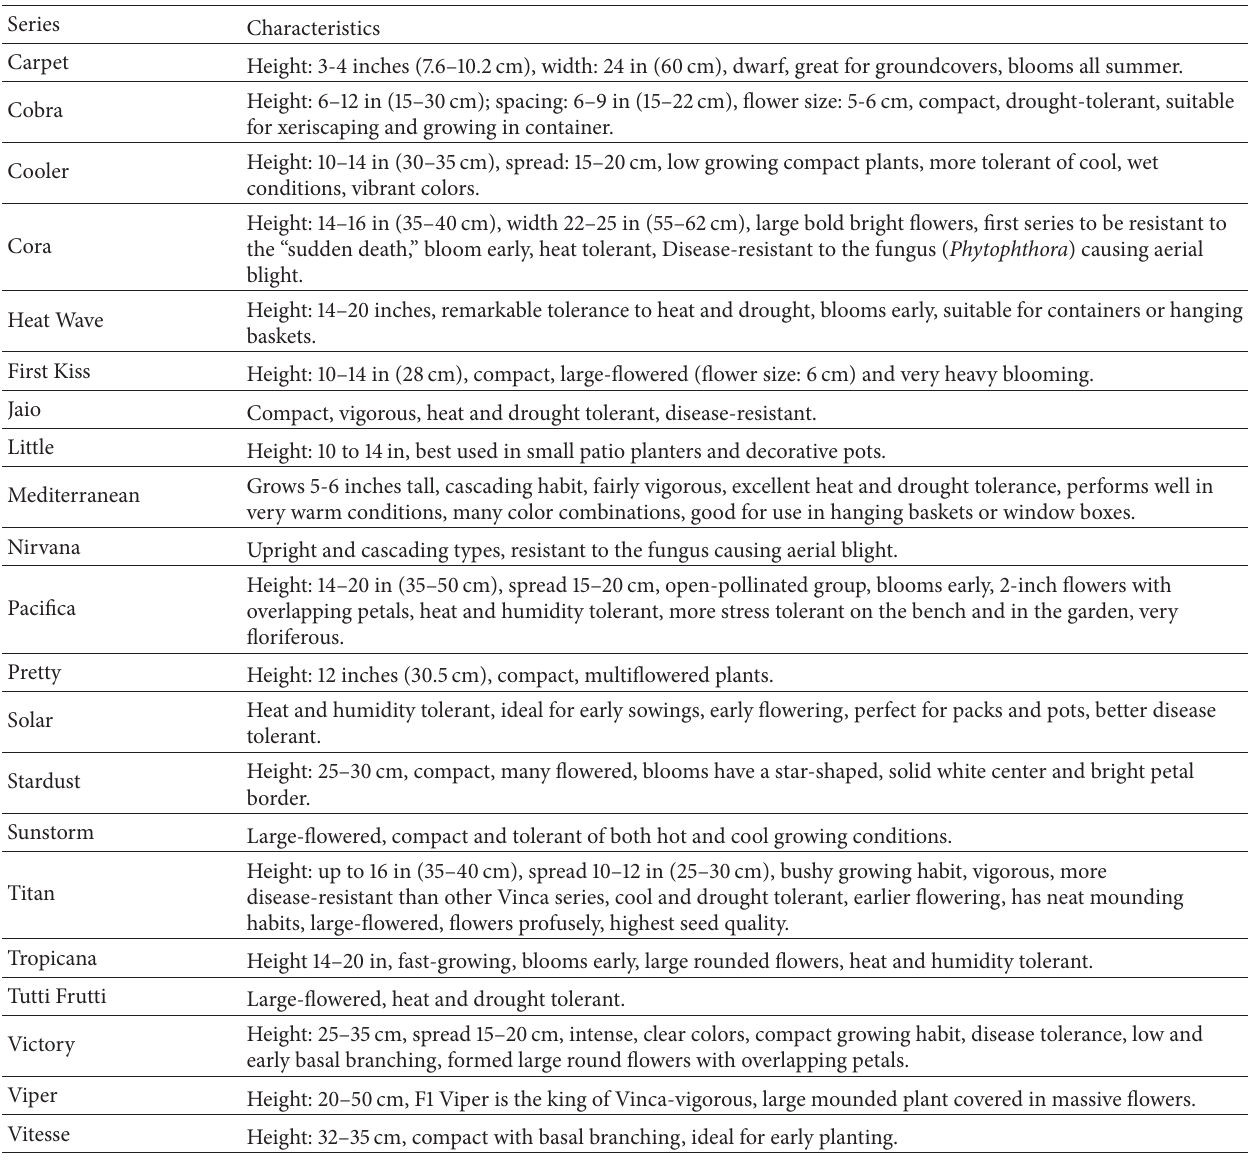
Table 3: Catharanthus roseus